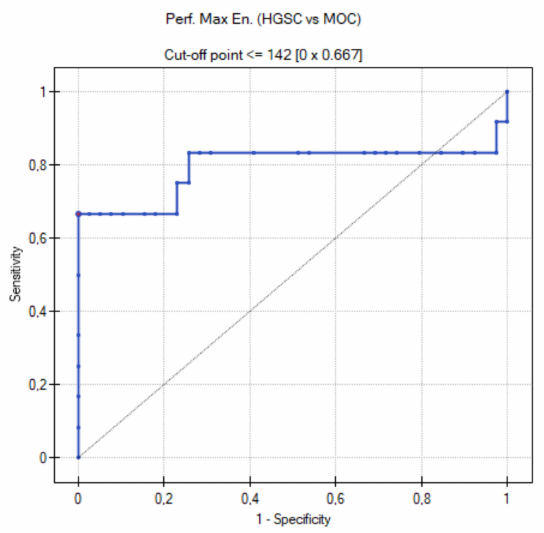
Figure 16. ROC curve for diagnostic performance of Perf. Max. En. parameter in detection of EOC (HGSC vs.